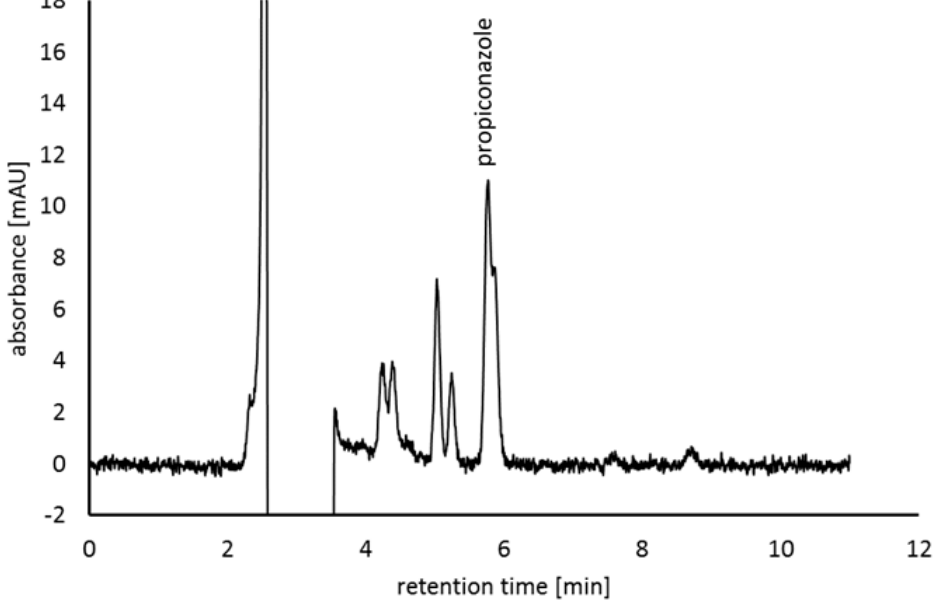
Figure 5. A chromatogram of propiconazole concentration in the sample with Sphingomonas sp. JX444564 (S11)